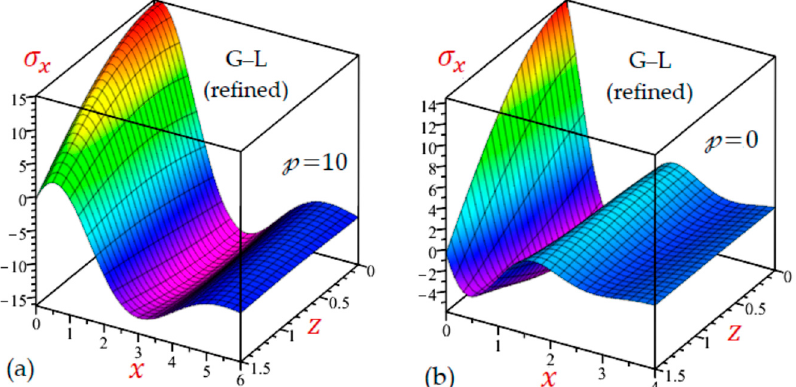
Figure 21. 3D distributions of the longitudinal normal stress σ 1 of the rotating half-space: ( a ) with initial pressure ( (cid:112) = 10); ( b ) without initial pressure ( (cid:112) = 0) using the refined G–L generalized theory.